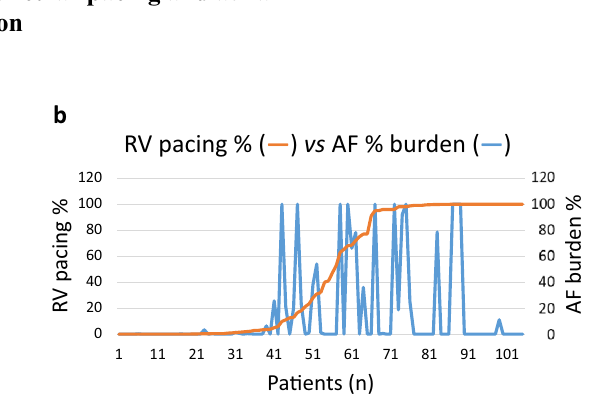
Fig. 3 Relationship between right ventricular pacing and atrial fibrillation. a Bar graph depicting the relationship between atrial fibrillation (AF)% burden ( y ‑axis) and right ventricular pacing (RVP)% ( x ‑axis). Note that patients with RVP burden of < 5% had the lowest AF burden. b Line graph depicting the relationship between AF% burden (blue line; y ‑axis on the right) and RVP% (orange line; y ‑axis on the left) for all the studied patients ( x ‑axis) aligned from left to right in an increasing order of RVP%. Note a precipitous increase in AF burden (blue line) as RVP% increases (orange line) after patient 31 on x ‑axis. Also note that patients with high RV pacing (patient > 81 on x ‑axis) also had high AF burden as opposed to ventricular